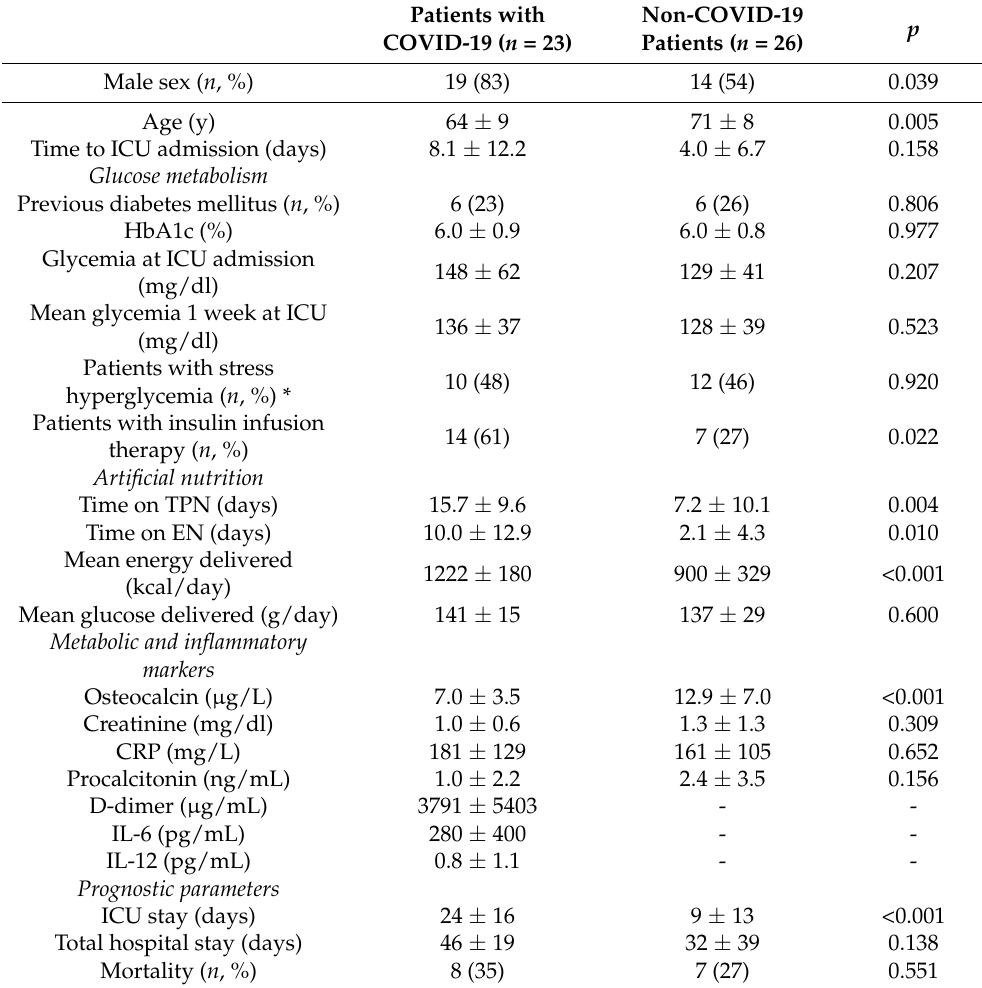
Table 1. Characteristics of the critically ill included